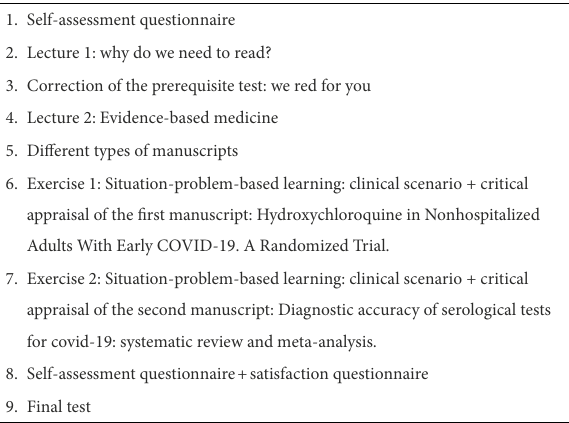
TABLE 1 The workshop’s detailed